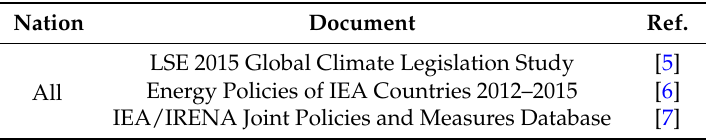
Table 5. Third party legislation, policy and policy measure analysis